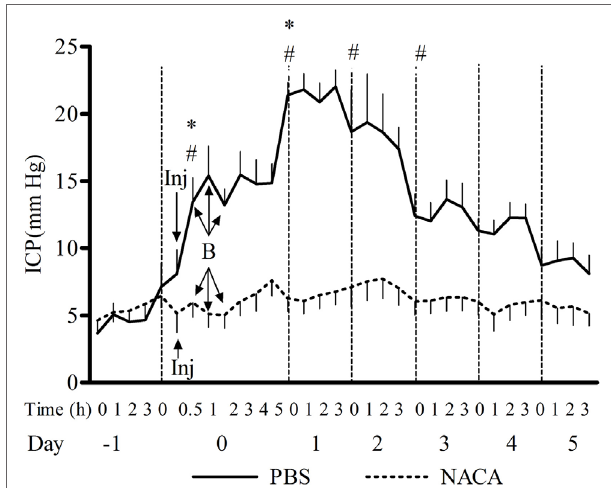
FigUre 2 | changes in intracranial pressure (icP) after exposure to 3 × 110 kPa blast overpressure (BOP) and the effect of N - acetylcysteine amide (naca) when administered 15 min before the first BOP exposure . X -axis label is not to scale. B, blast; Inj, injection of NACA/phosphate-buffered saline (PBS). Significant difference in ICP between a given time point and the one preceding it within PBS-treated group is shown by * (one-way ANOVA) and between the two groups is shown by # (two-way RM ANOVA), with p <